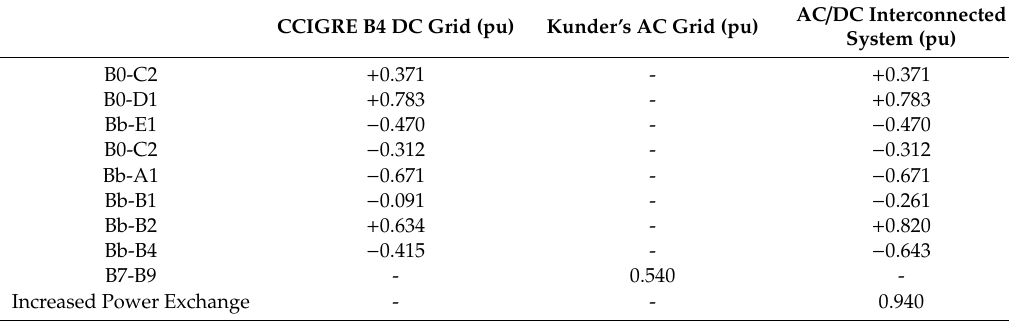
Figure 10. Power profile for interconnected AC/DC systems till the system becomes unstable. Table 7. Load flow results at transmission limits of Standalone Kunder’s network and Interconnected AC / DC